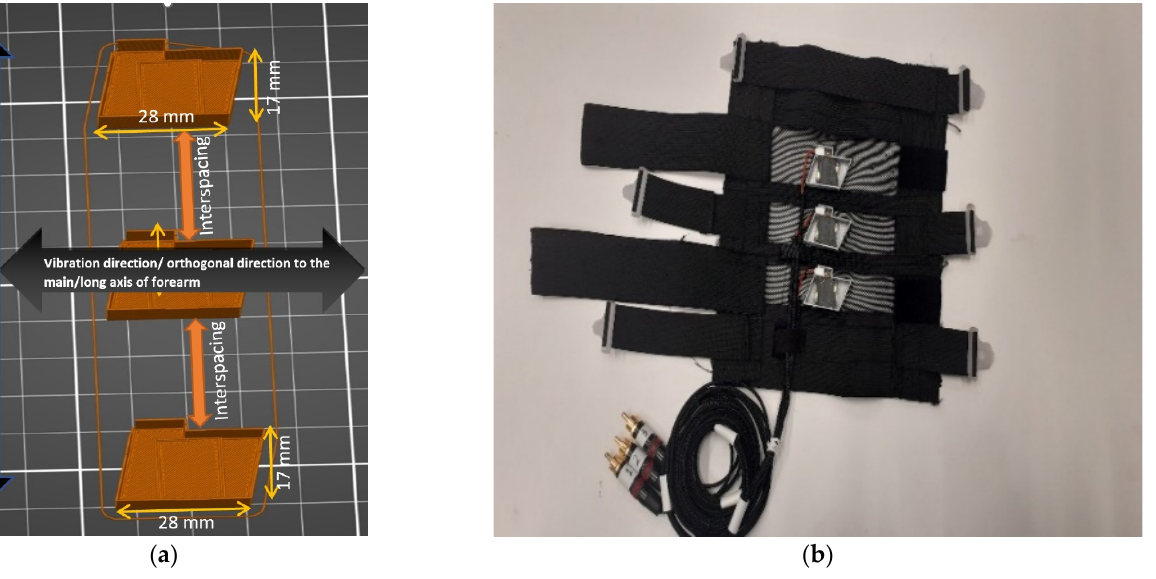
Figure 2. ( a ) Overview of designing the Lofelt L5 actuators along the forearm; and ( b ) an example of a wearable vibrotactile sleeve and the configuration of the actuators. a wearable vibrotactile sleeve and the configuration of the